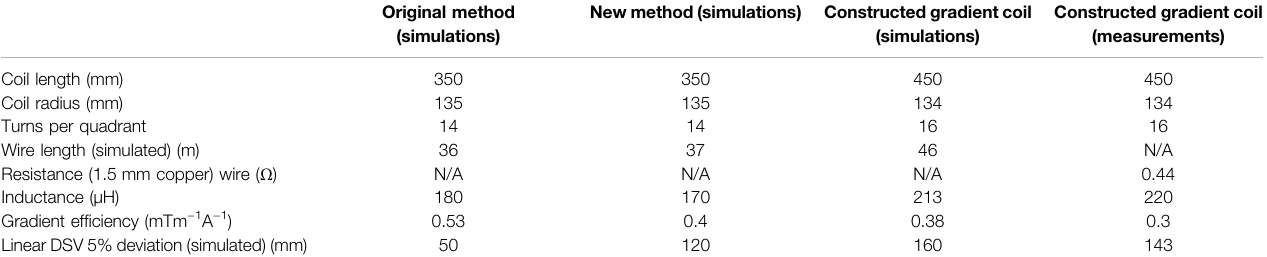
TABLE 1 | Characteristics of the simulated gradient coils designed using the original method and the new method (axial length 350 mm) and the actual constructed longer coil (450 mm) designed with the new method.